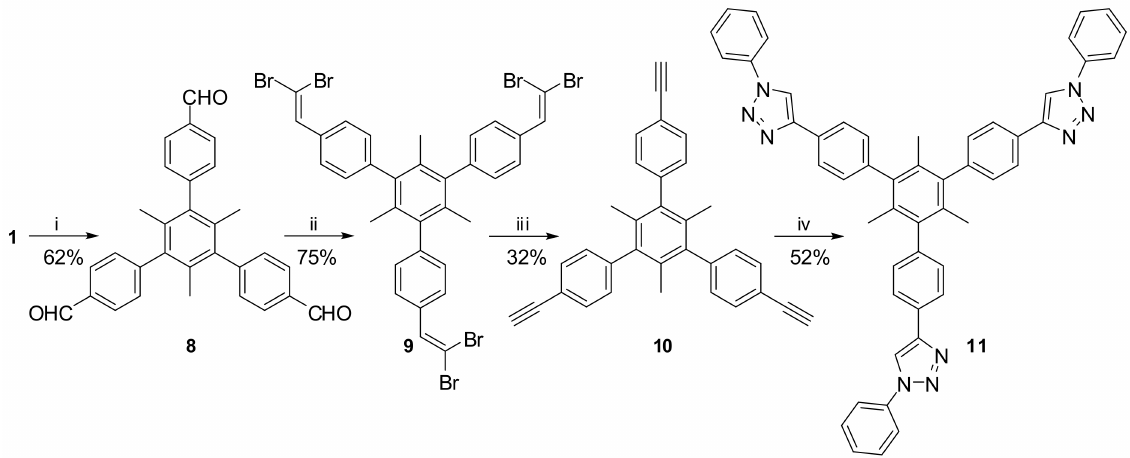
Scheme 2. The synthesis of triazolyl linker 11 . Reaction conditions are as follows: ( i ) 4-formylphenylboronic acid, K 2 CO 3 ,